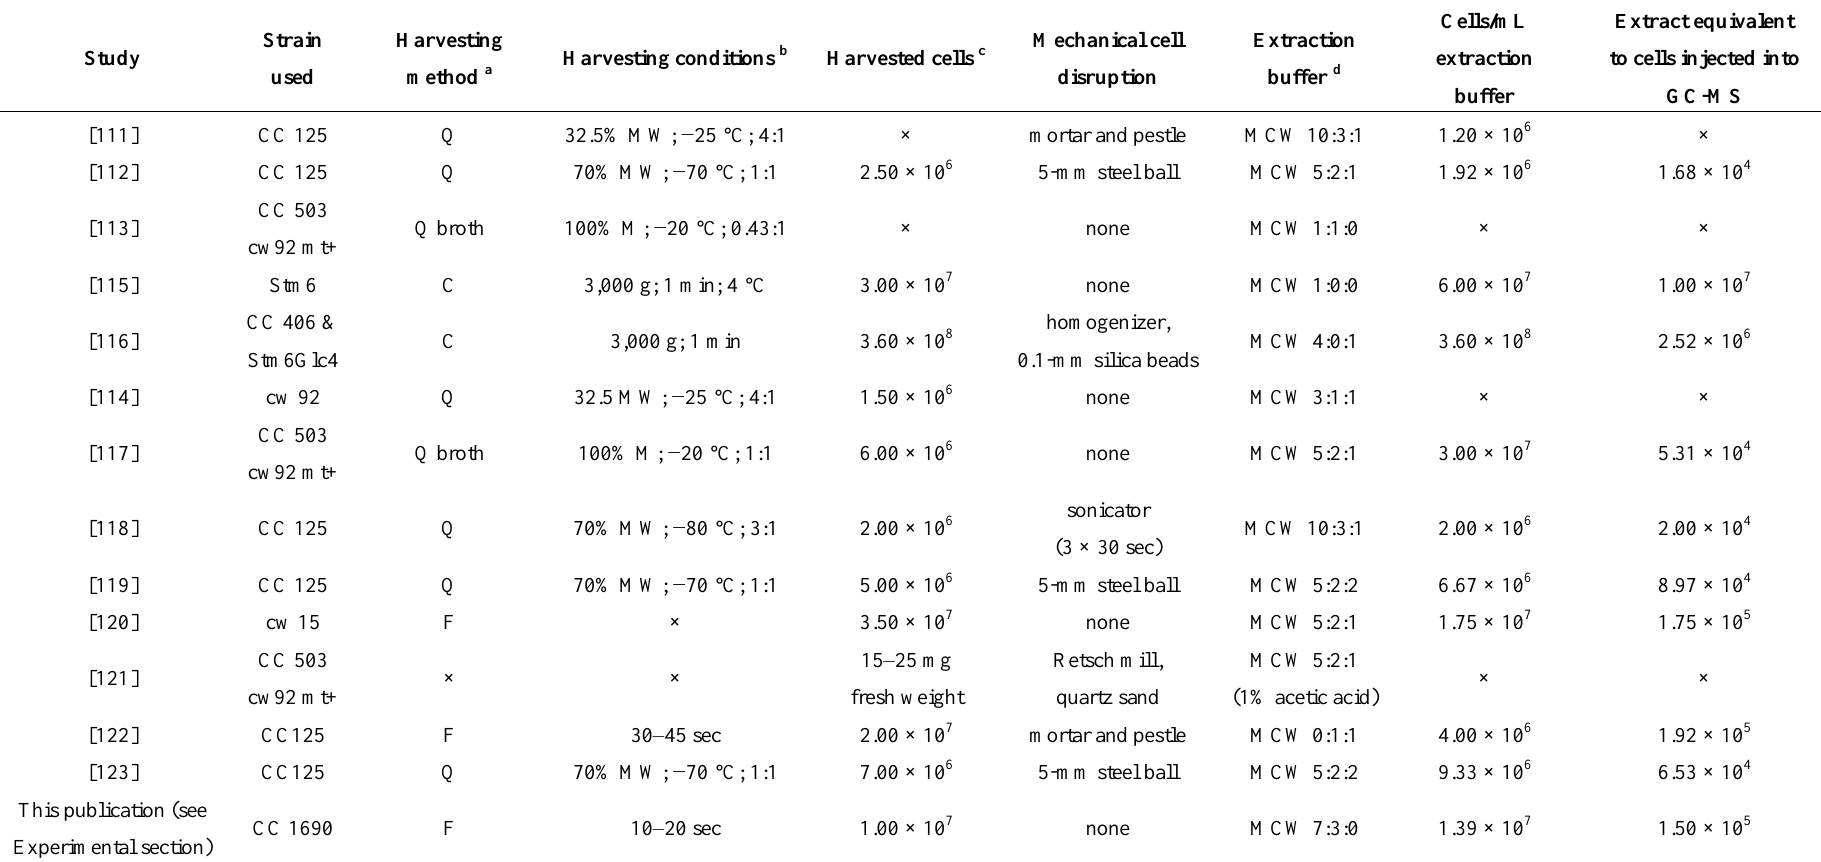
Table 2. Comparison of the methods for sampling, extraction and sample workup of GC-MS based metabolite profiling studies in Chlamydomonas . Strain Harvesting Study used method